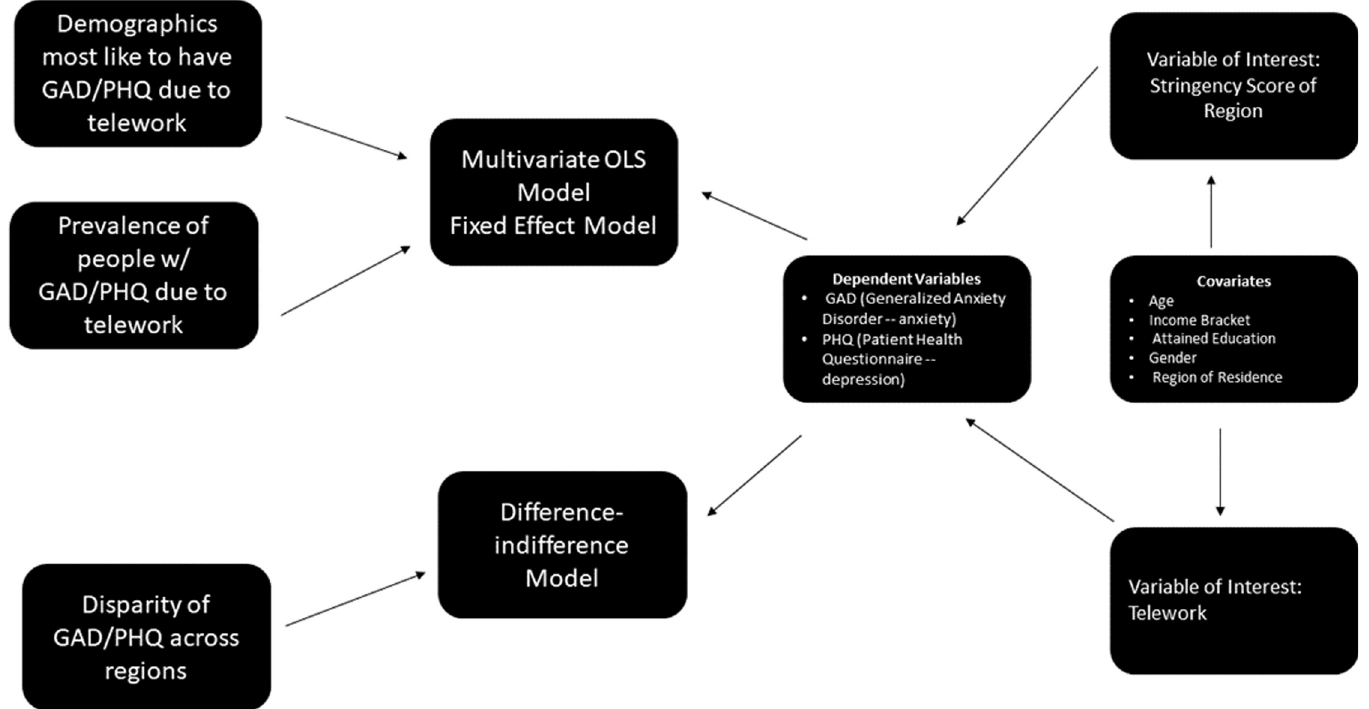
Fig 1. Flow chart illustrating conceptual